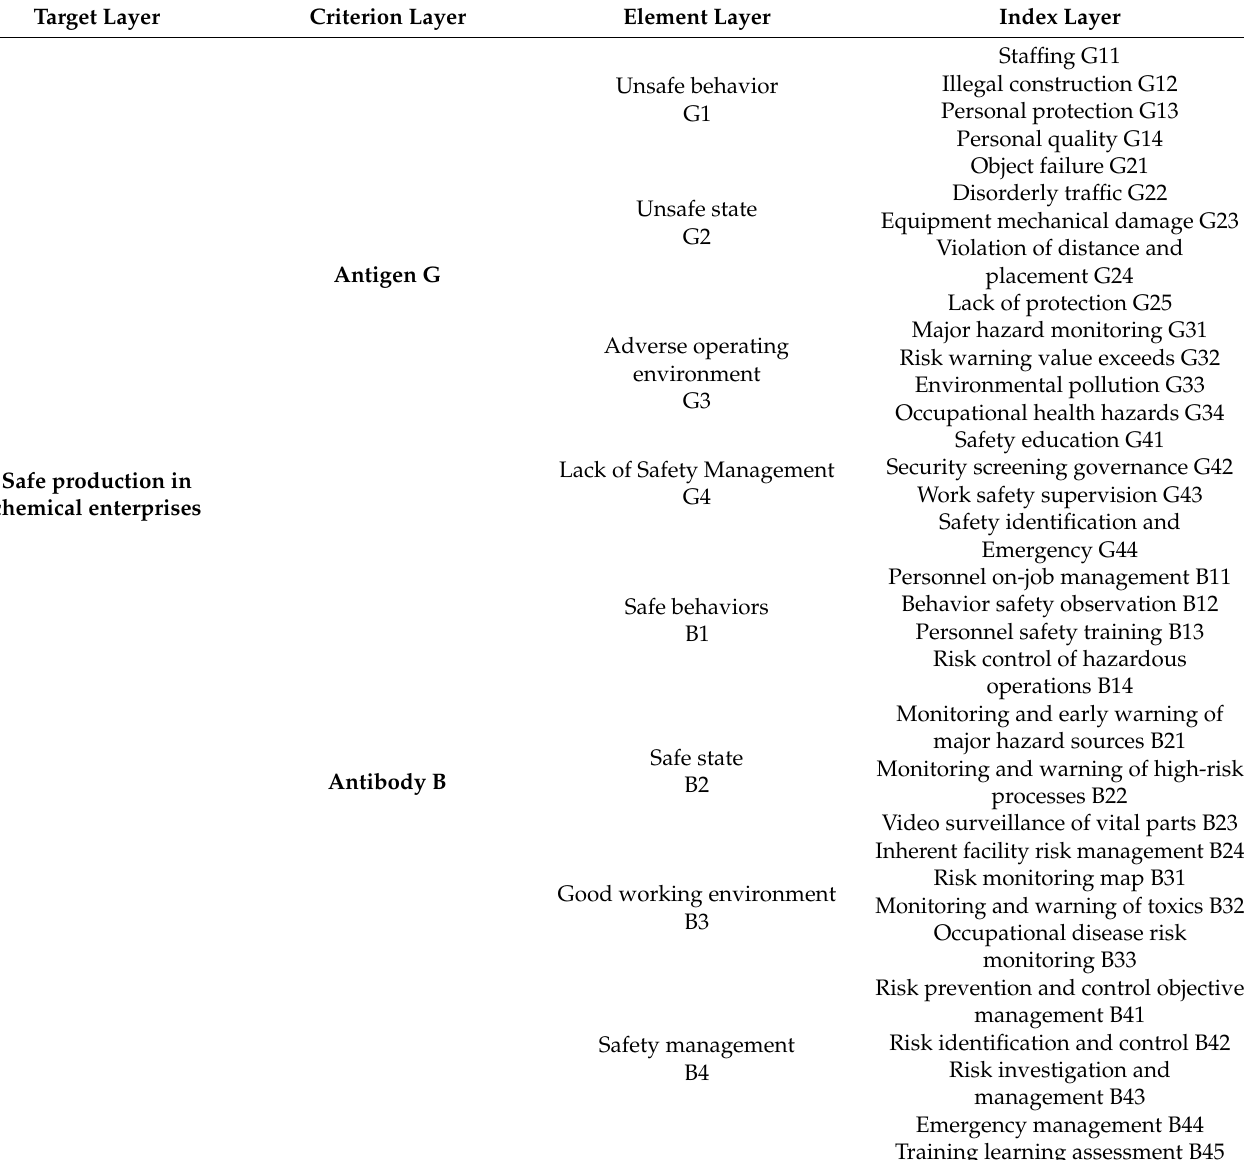
Table 1. Safety production index system of chemical enterprises based on immune